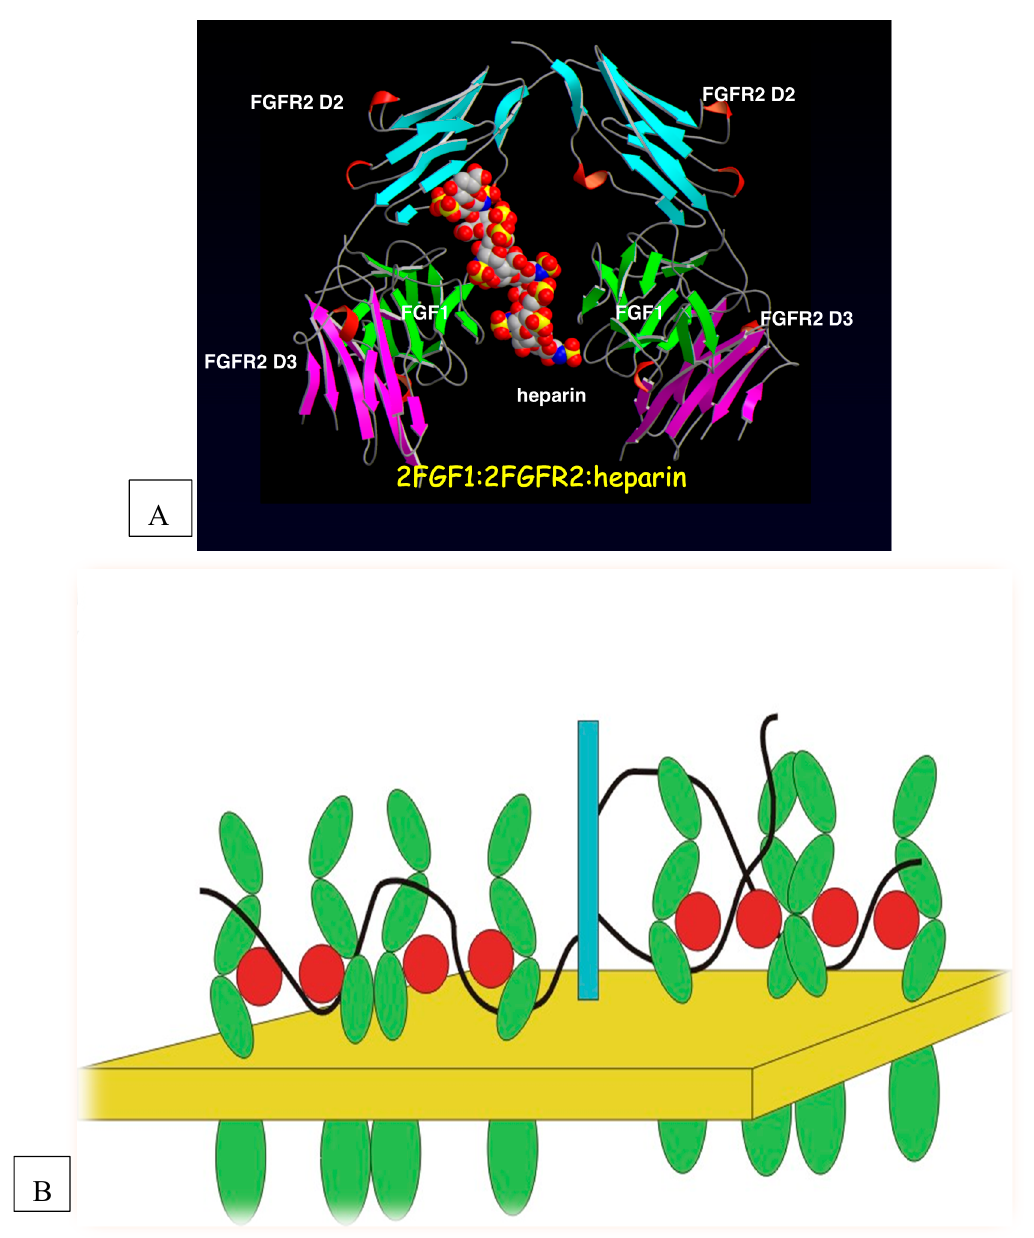
Figure 8. ( A ) The crystal structure of the basic repeat unit of the extracellular domain of the 2FGF: 2FGFR:1heparin complex. With extended heparin it forms a 2D repeat higher-order complex on the cell surface. ( B ) A schematic of the higher-order signalling complex, in which the heparan sulphate (blue and black lines), links the FGFR receptors (green) and FGF (red) [87].